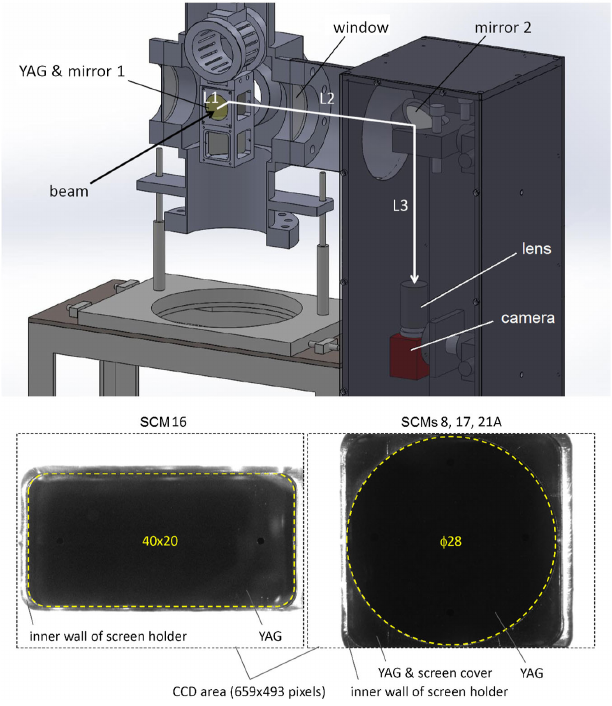
FIG. 3. Schematic of the screen monitor system with a 12-bit CCD camera and a YAG:Ce screen (top). Comparison of sizes of the YAG:Ce screens and the CCD camera screen images